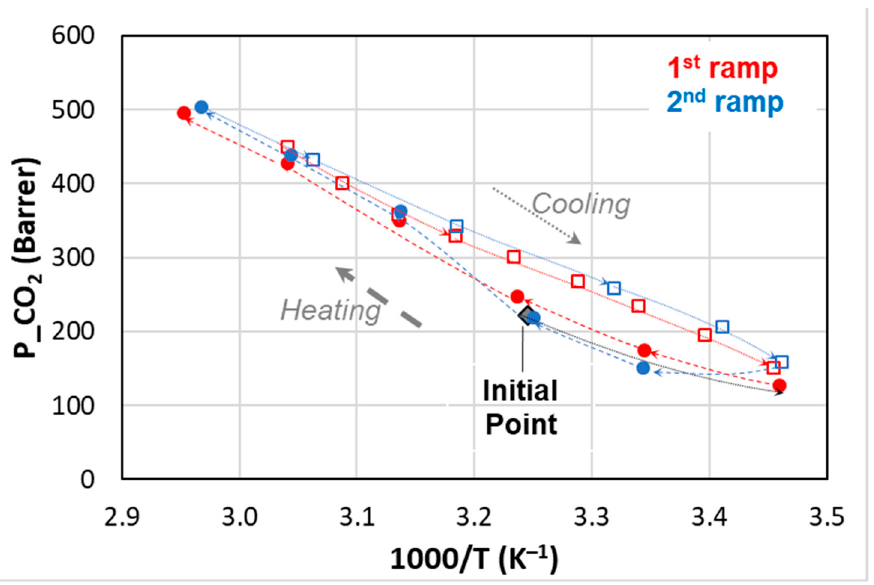
Figure 11. Temperature effect on CO 2 permeability for Rnew–10% IL2 composite membrane. Closed symbols: heating; open symbols: